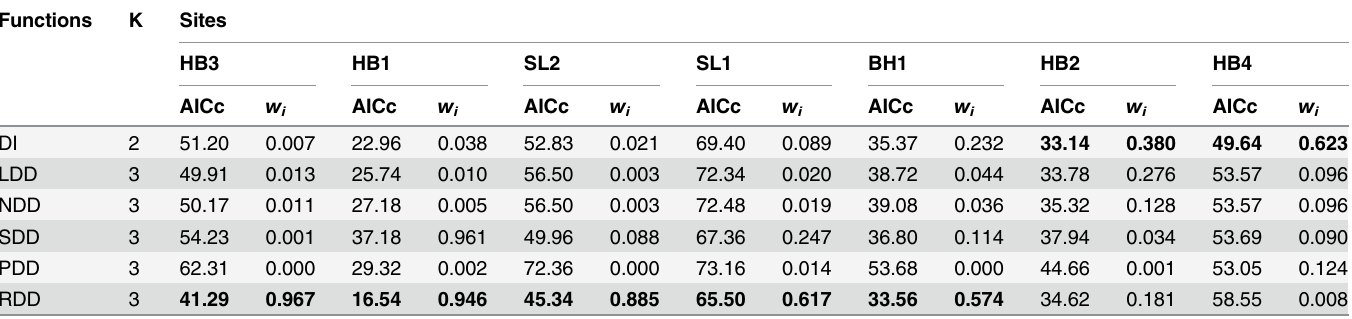
Table 2. AICc scores (AICc) and Akaike weights (w i ) for each of the six empirical functions predicting the observed number of immigrants arriving on the site following a removal event in relation to population size of damselfish following that removal event (site scaling) on seven experimental sites. For each site, the function with the highest support is indicated by bold fonts for the AICc and w i . Sites are ordered as in Fig 1. See Fig 1 for site abbrevi- ations and Table 1 for the functions. Functions